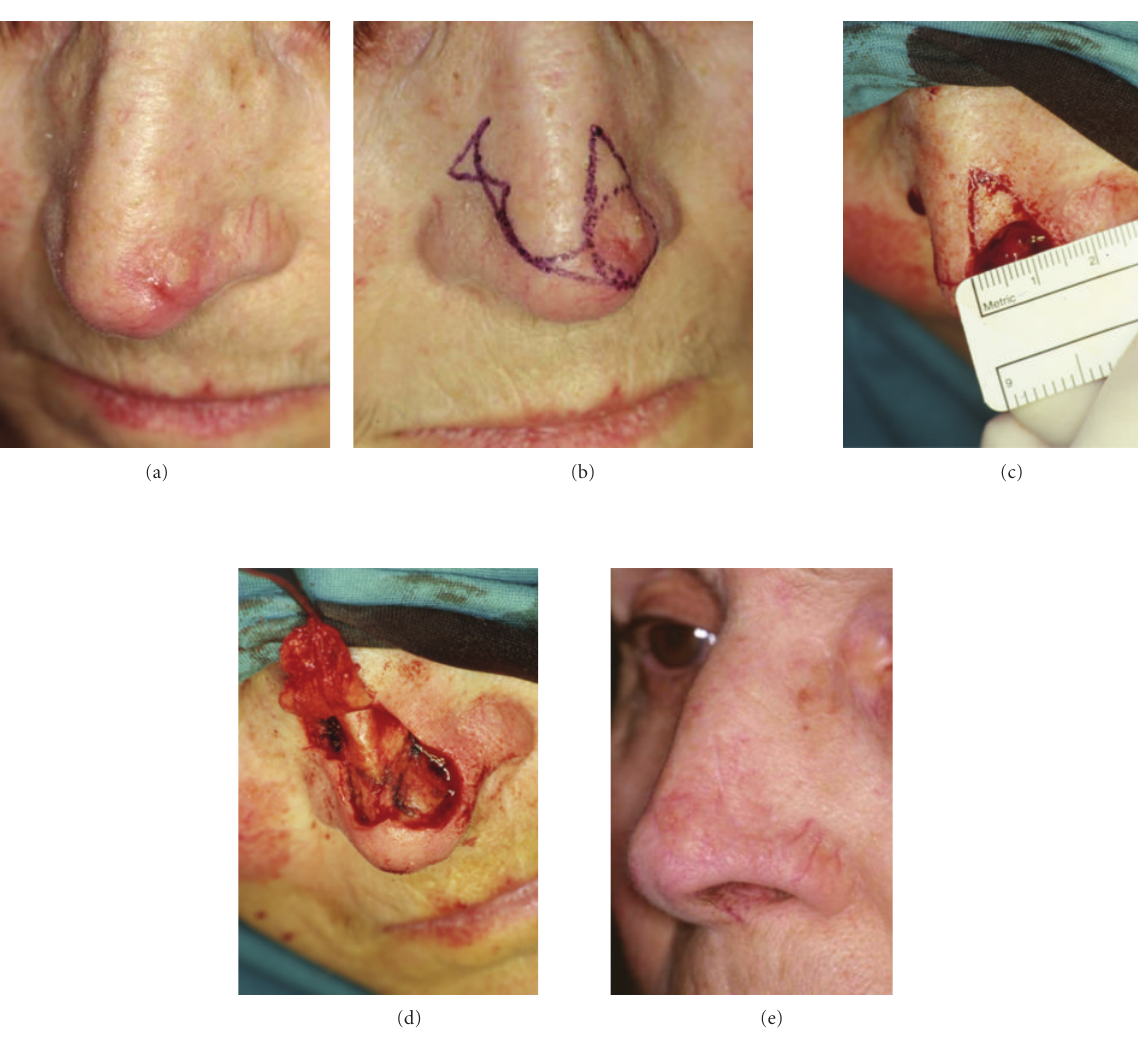
Figure 3: (a) BCC involving the lateral tip of the nose. (b) Zitelli’s flap design. (c) Tumour resection. (d) Intraoperative view: double trans- position flap. (e) Nasal appearance two years after